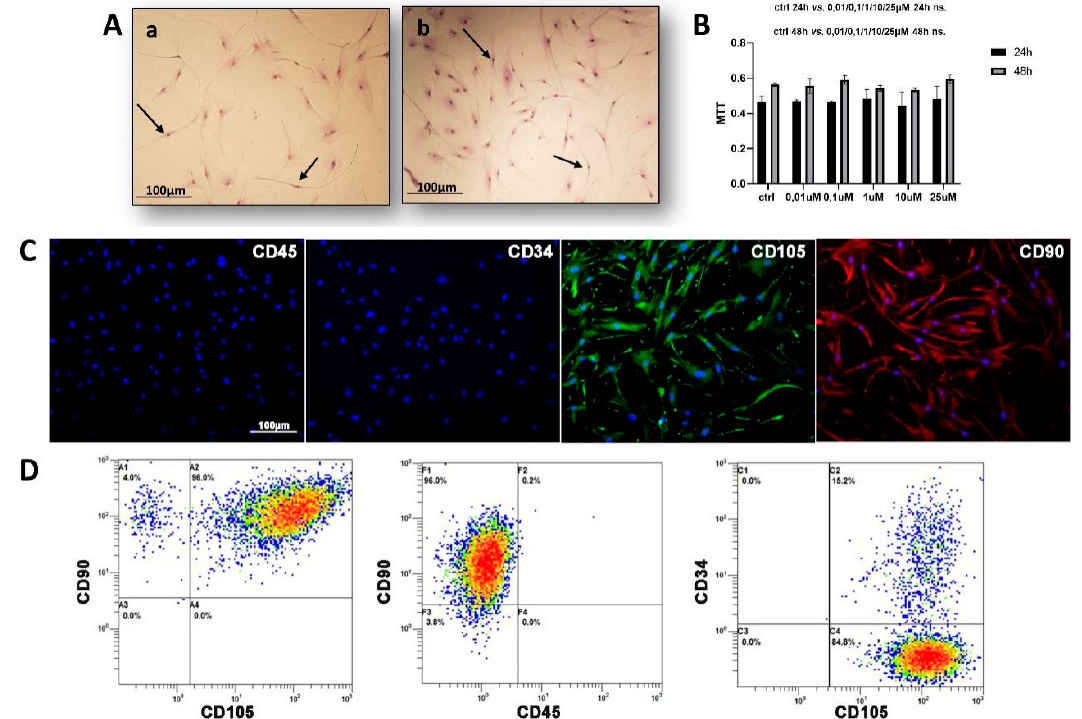
Figure 1. ( A ) The micrographs (a,b) of adipose tissue-derived mesenchymal stem cells (AMSCs) cultured in basal medium at di ff erent passages (Aa: p. 10; Ab: p. 12), evidenced by May–Grünwald Giemsa staining. The AMSCs show a characteristic fibroblast-like morphology (black arrows). Objective